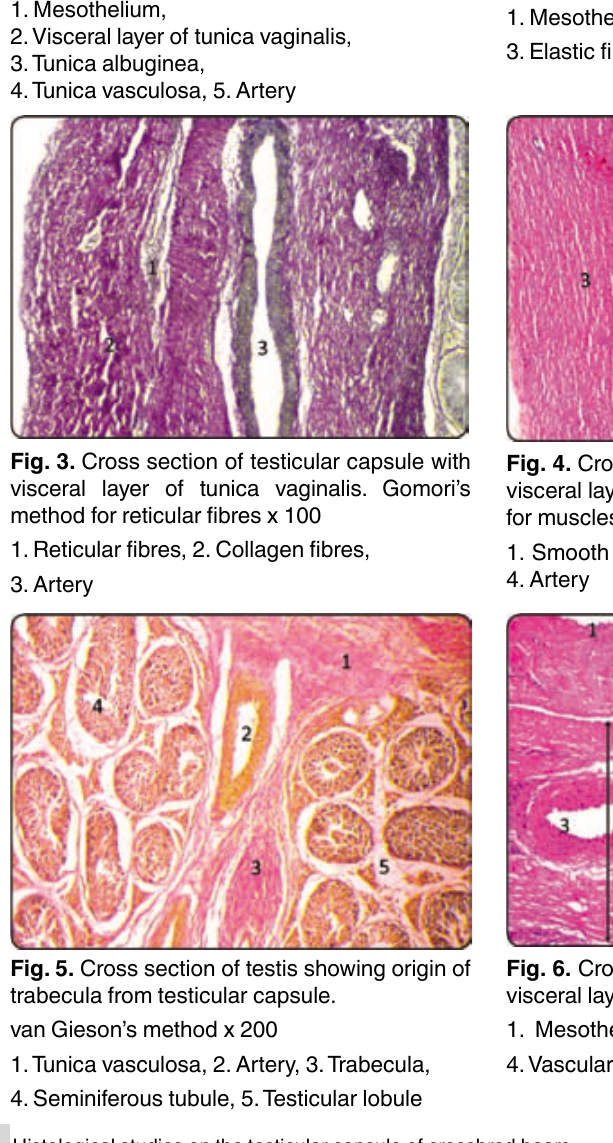
Fig. 1. Cross section of testicular capsule with visceral layer of tunica vaginalis. Masson’s trichrome method x 100